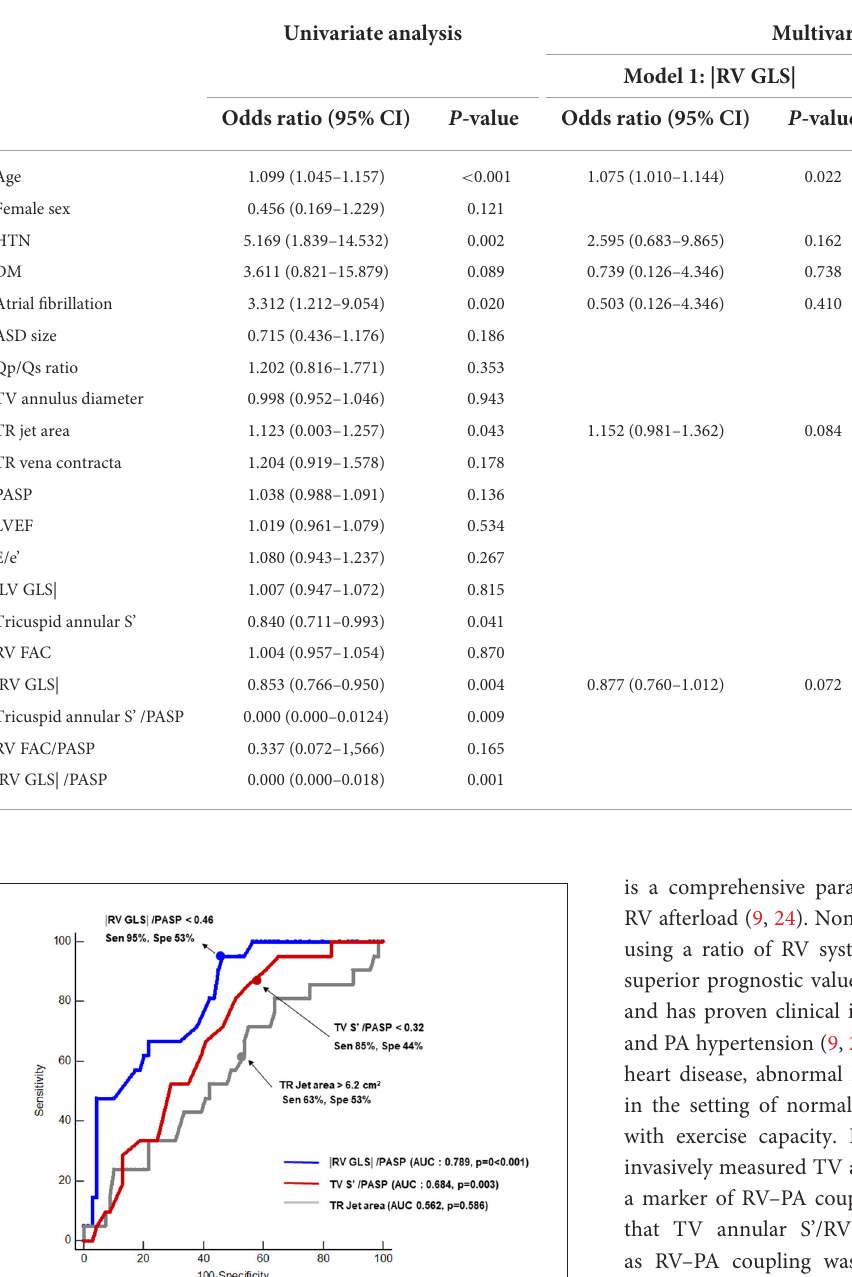
TABLE 4 Pre-procedural factors associated with persistent TR after ASD closure.